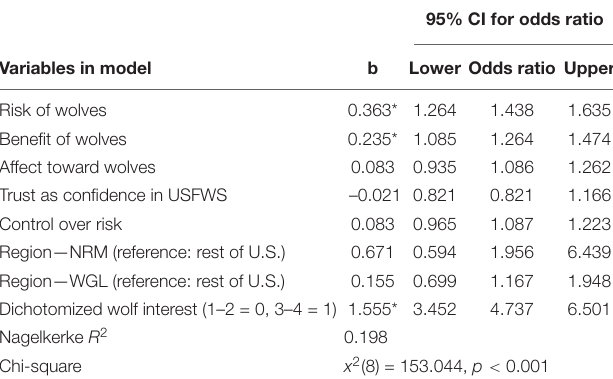
TABLE 2 | Weighted logistic regression results predicting any likely or uncertain action reported by respondents (respondents unlikely to take any action coded as 0).